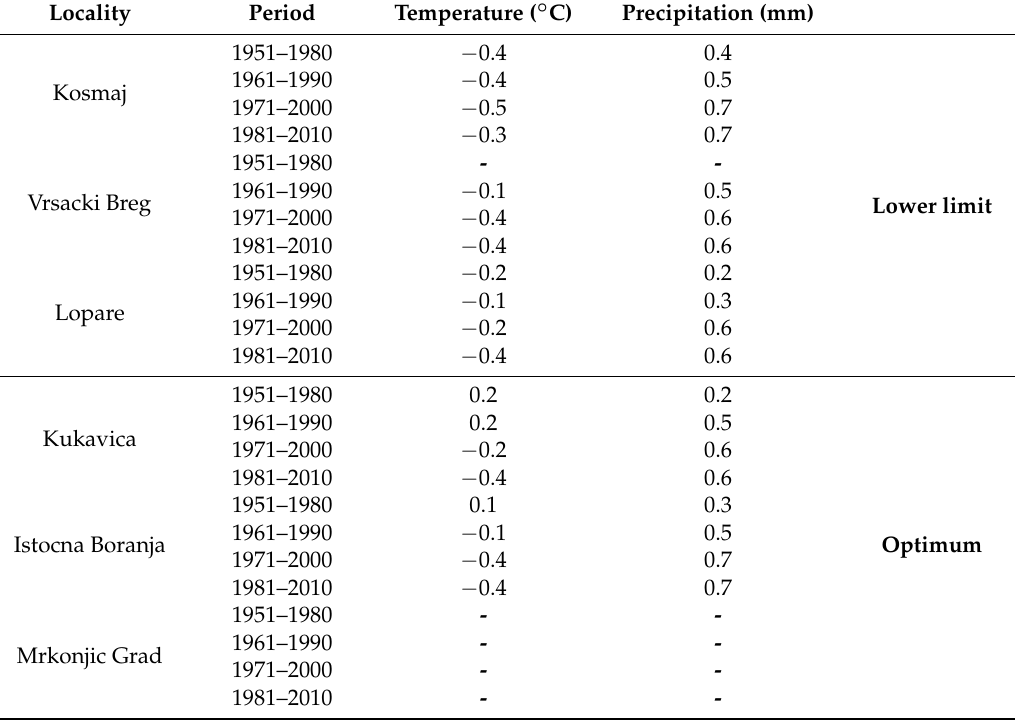
Table 4. Coefficient of correlation between changes in TRW and temperature and precipitation during the GS.